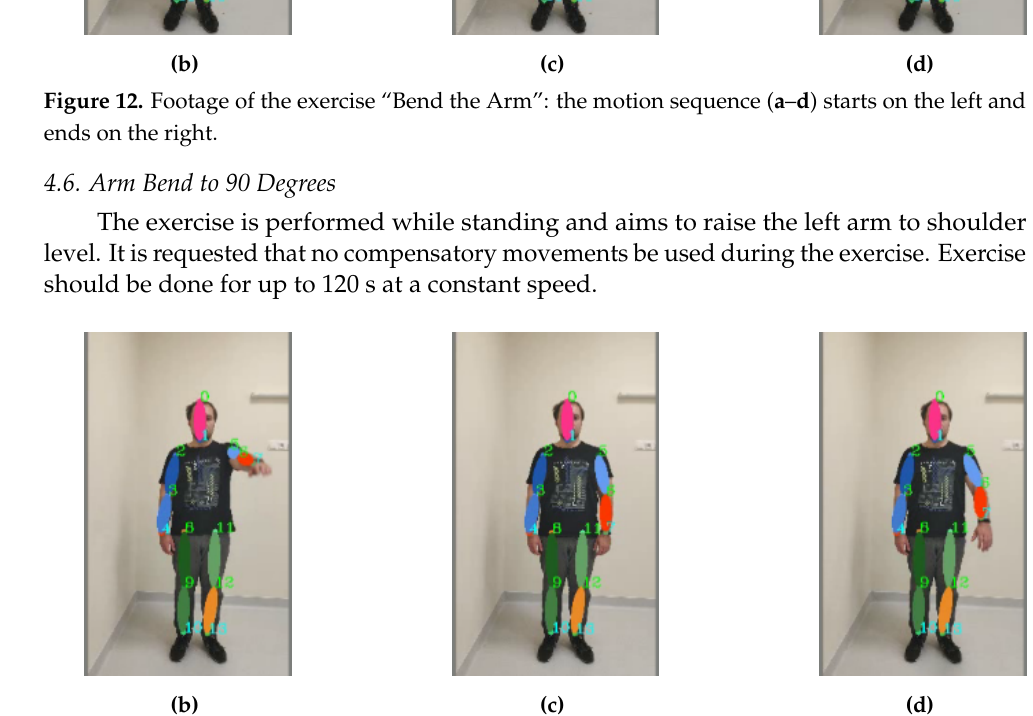
Figure 13. Arm bending up to 90 degrees freestyle exercise footage: the motion sequence ( a – d ) starts on the left and ends on the